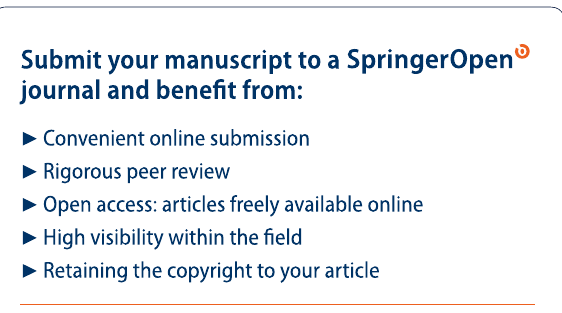
Ziegler PA. Late Cretaceous and Cenozoic intra-plate compressional deformations in the Alpine foreland - a geodynamic model. Tectonophysics. 1987;137:389–420. Ziegler M, Heidbach O. The 3D stress state from geomechanical–numerical modelling and its uncertainties: a case study in the Bavarian Molasse Basin. Geotherm Energy. 2020;8:11. https:// doi. org/ 10. 1186/ s40517- 020- 00162-z. Publisher’s Note Springer Nature remains neutral with regard to jurisdictional claims in published maps and institutional